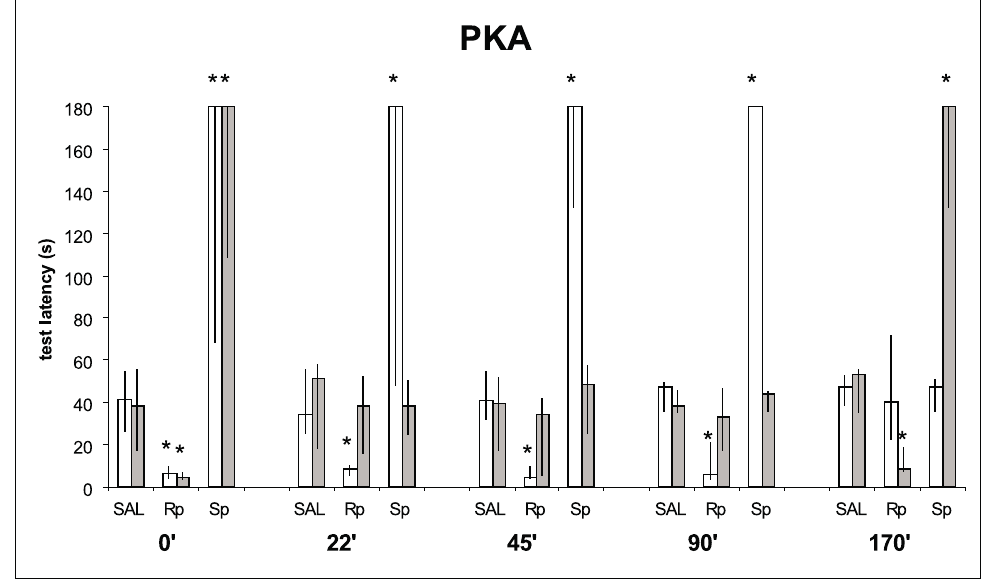
Fig. 2 – Same training-test procedures as in Figure 1. Data from this figure is published elsewhere (Vianna et al. 2000a). Rats received post-training bilateral infusions in the dorsal CA1 region of saline, of the selective inhibitor of the regulatory site of PKA, Rp-cAMPS (0 . 5 µ g/side), or of the selective stimulant of that site, Sp-cAMPS (0 . 5 µ g/side). The infusions were: 0, 22, 45, 90 or 170 min after training. STM testing was at 90, 112, 135, 180, 180 and 180 min after training respectively. ∗ Indicates significant difference from control values at p < 0 . 001 level. In groups not marked by asterisks the training-test latency differences were significant at a p < 0 . 001 level. The PKA inhibitor given 0 min post-training inhibited both STM and LTM, given 22-90 min after training it inhibited STM but not LTM, given 170 min after training LTM but not STM. The time-course of the effect of Rp-cAMP-RS reproduces that obtained using an inhibitor of the catalytic site of the enzyme, KT5720 (Vianna et al.